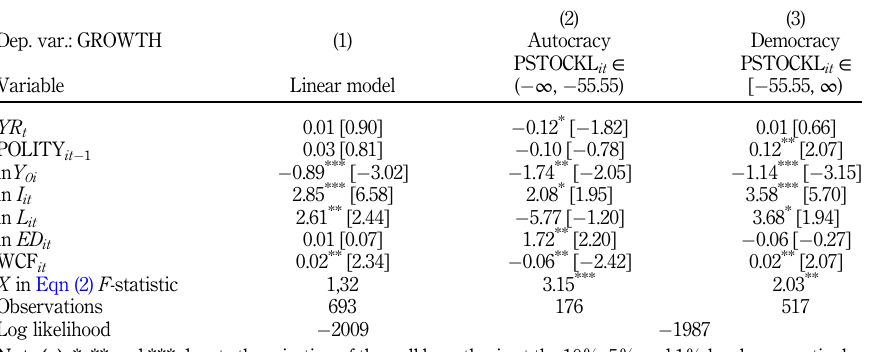
Table 5. Estimation results of linear and two-regime panel threshold